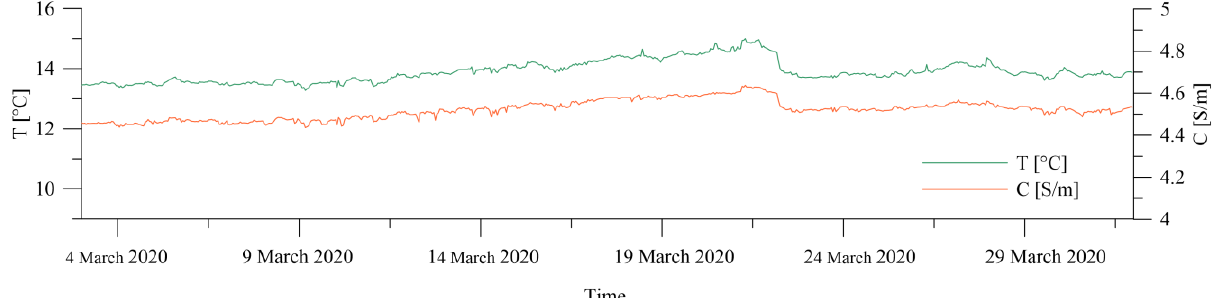
Figure 5. Time series of measured water temperature [°C] and conductivity [S/m] in March 2020. Time is local time.